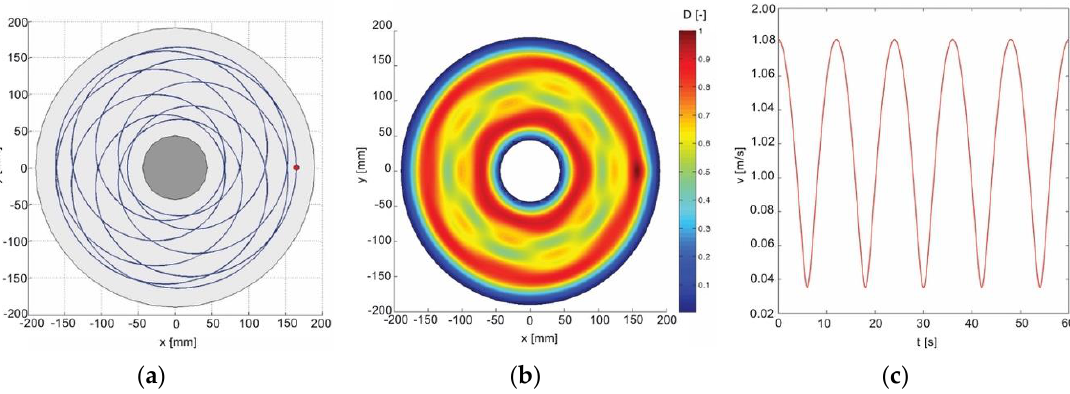
Figure 3. The influence of the parameter k 1 = 5 / 9 on: ( a ) the shape of the abrasive grains trajectory; ( b ) the trajectories density on the lapping plate; and ( c ) the distribution of relative velocities v ( t ).